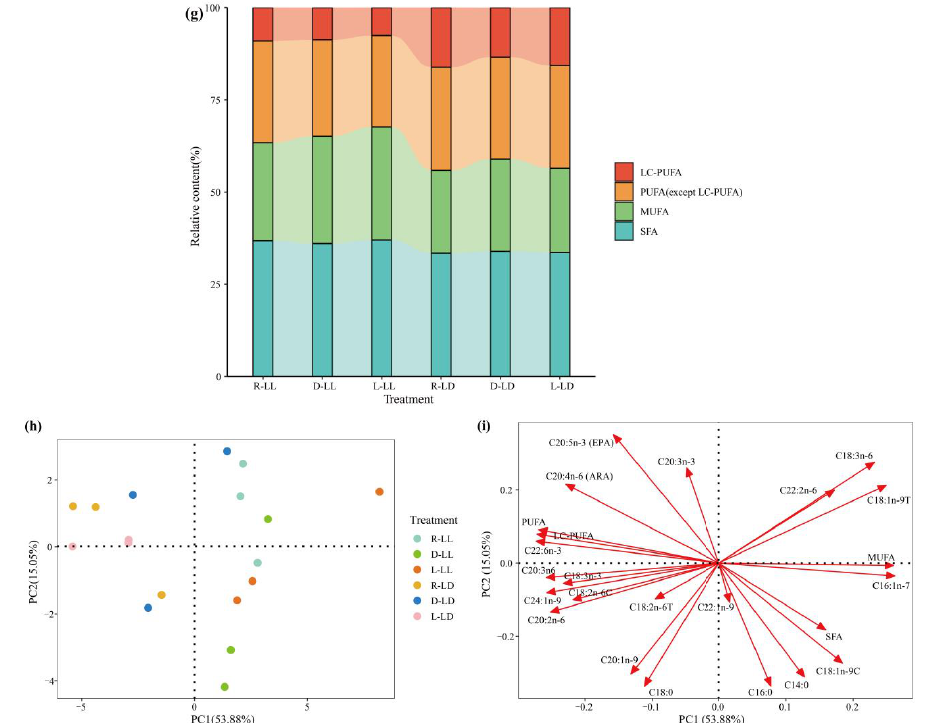
Figure 2. Fatty acids profile of juvenile Oncorhynchus mykiss under different experimental treat- ments. ( a ) Proportion of liver fatty acids; ( b ) PCA score plot of liver fatty acids; ( c ) PCA loading plot of liver fatty acids. ( d ) Proportion of serum fatty acids; ( e ) PCA score plot of serum fatty acids; ( f ) PCA loading plot of serum fatty acids. ( g ) Proportion of dorsal muscle fatty acids; ( h ) PCA score plot of dorsal muscle fatty acids; ( i ) PCA loading plot of dorsal muscle fatty acids.